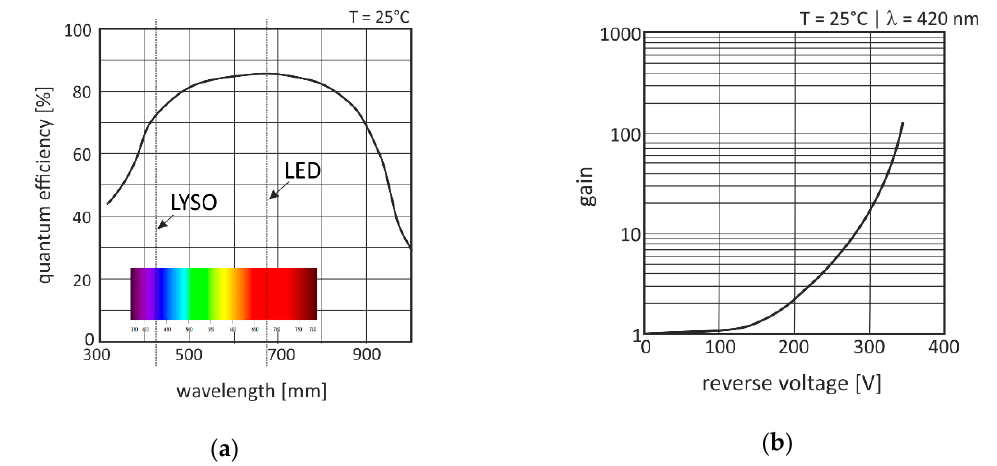
Figure 7. Selected properties of the avalanche photodiode (APD) array S8550 : ( a ) Quantum efficiency vs. wavelength and ( b ) internal gain vs. reverse voltage [37].